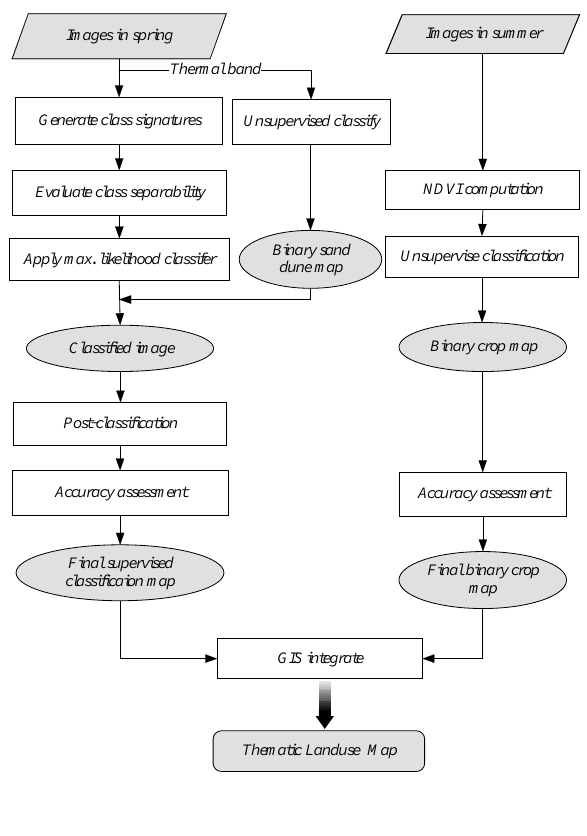
Figure 5. Procedure of image classification and land use